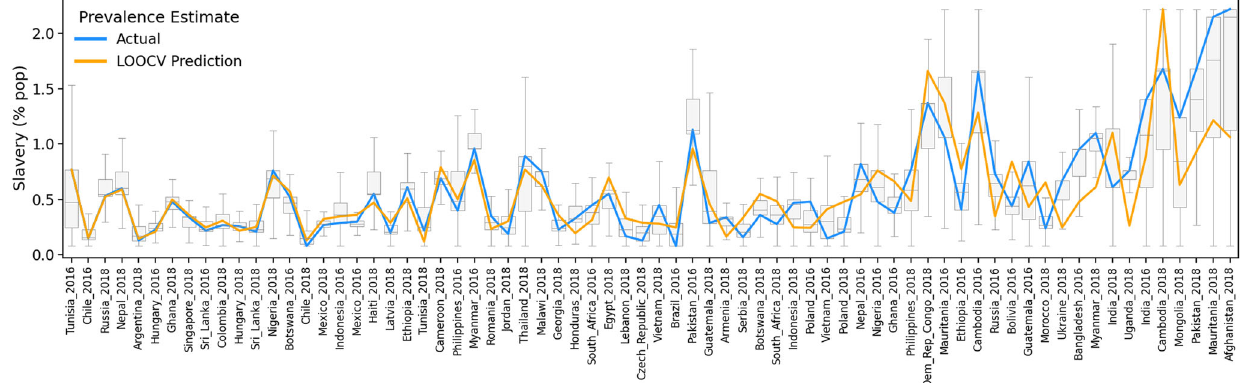
Fig. 2 The predictions of slavery prevalence (individuals enslaved as a % of the population) made by the best model using leave-one-out cross validation (LOOCV), compared to the “ actual ” prevalence as estimated using the Gallup World Poll (GWP) survey data. The grey box plots illustrate the distribution of 10,000 bootstrapped LOOCV predictions (using the full pipeline NMF → DT) to help illustrate the uncertainty associated with our model ’ s predictions. The box shows the quartiles of the bootstrapped predictions while the whiskers extend to show the rest of the distribution, except for points that were determined to be “ outliers ” (using a function of the inter-quartile range), which are not plotted. The x -axis is ordered by the MAE.